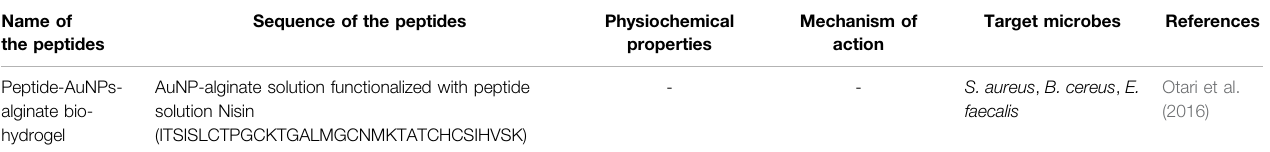
TABLE 3 | ( Continued ) Antimicrobial peptides: delivery vehicles, peptide hydrogels and peptide-nanoparticle conjugates.